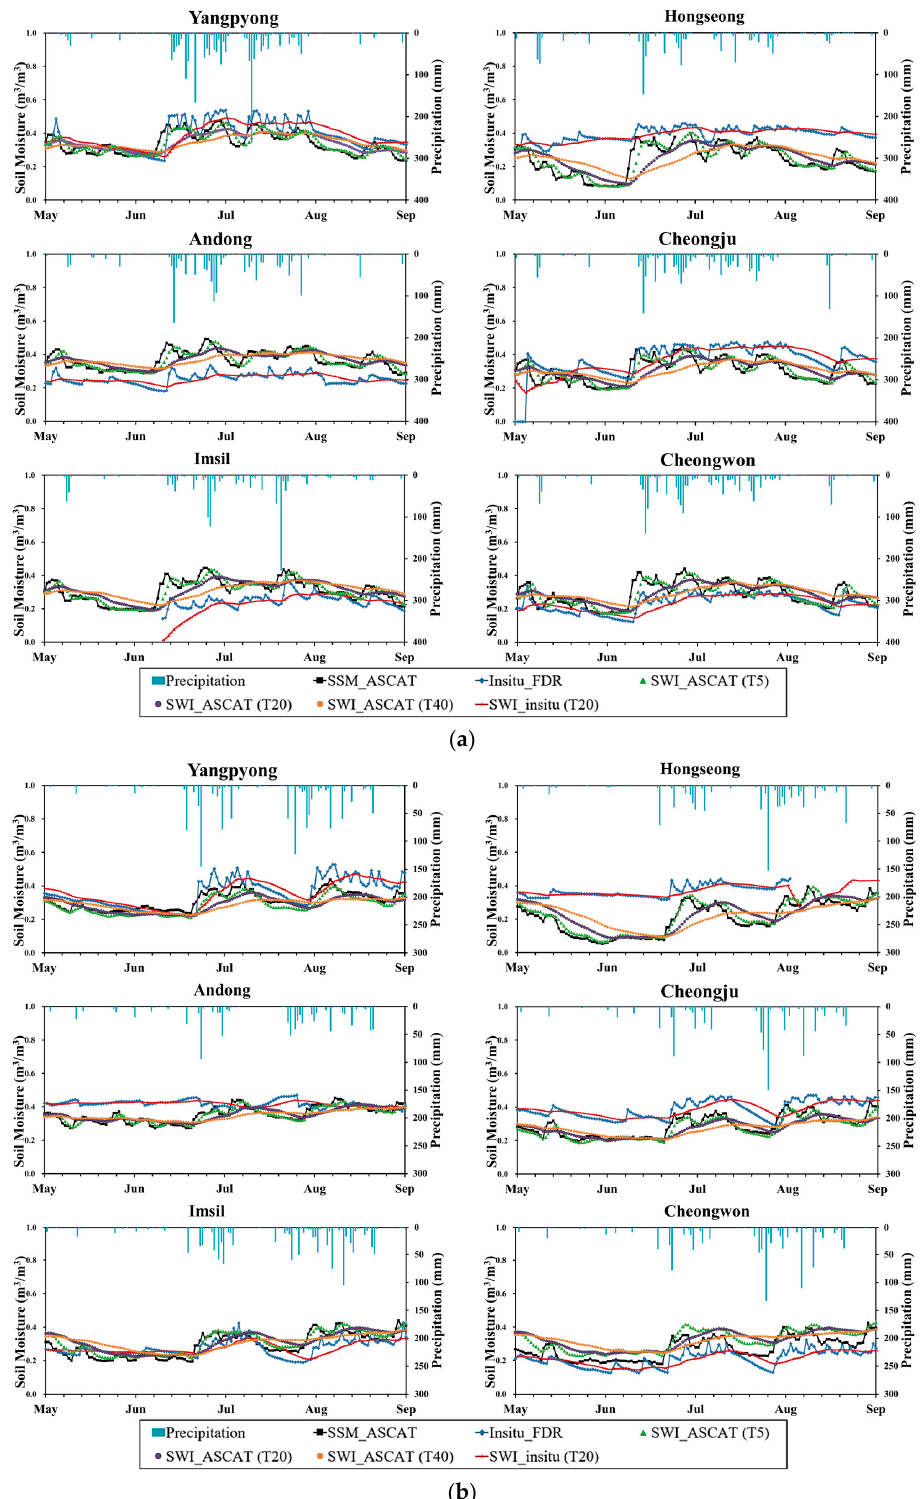
Figure 2. Temporal patterns of remotely sensed surface soil moisture (SSM), in situ soil moisture (10 cm), root zone soil moisture (RZSM) from soil wetness index ( T = 5, 20, 40) and weighted in situ soil moisture products (SWI_insitu, T = 20) with rainfall events from 1 May to 30 September: ( a ) 2011; and ( b ) 2012 at six sites in Northeast Asia.